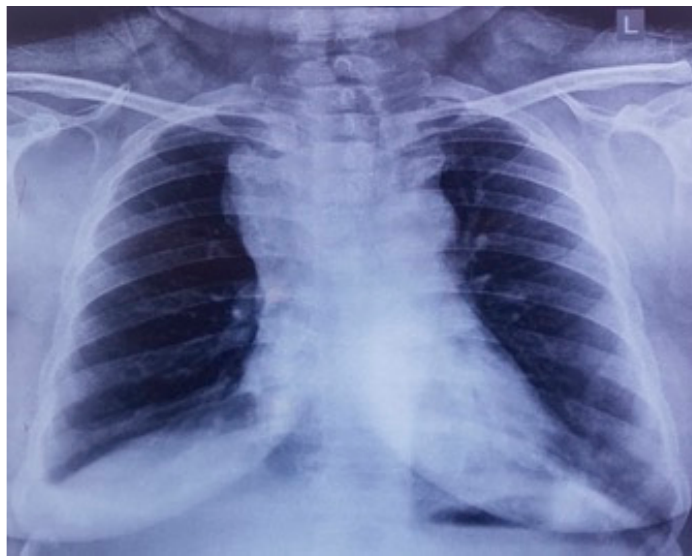
Figure 1. Chest X-ray showing widened superior mediastinum.